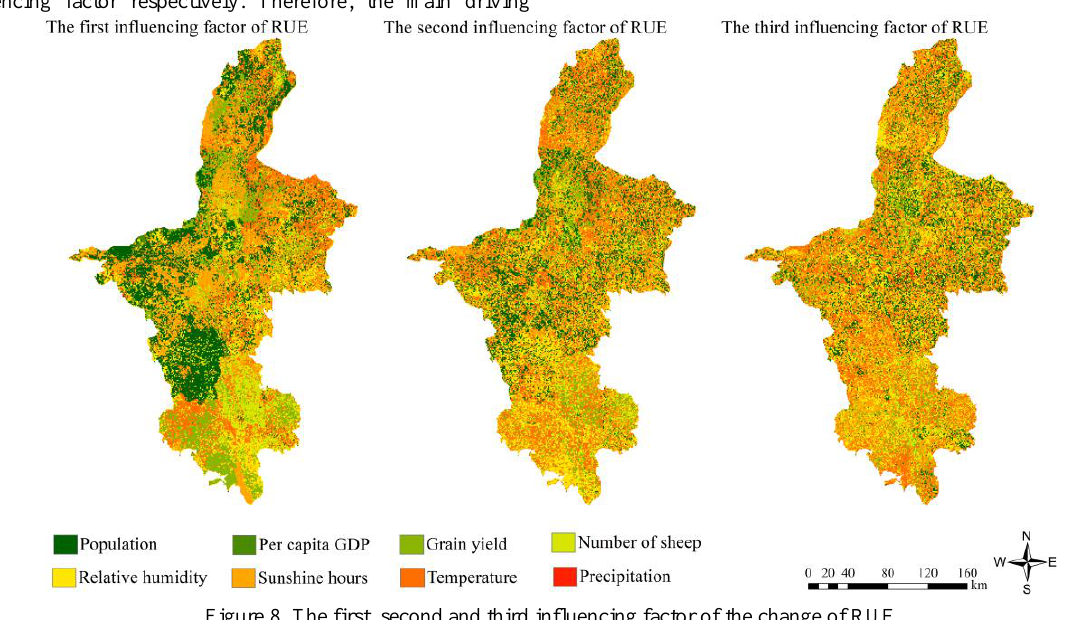
Figure 8. The first, second and third influencing factor of the change of RUE